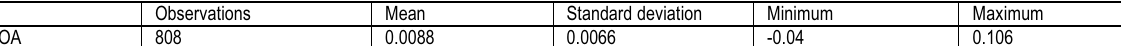
Table 2b Descriptive statistics for profitability measures of state-owned commercial banks